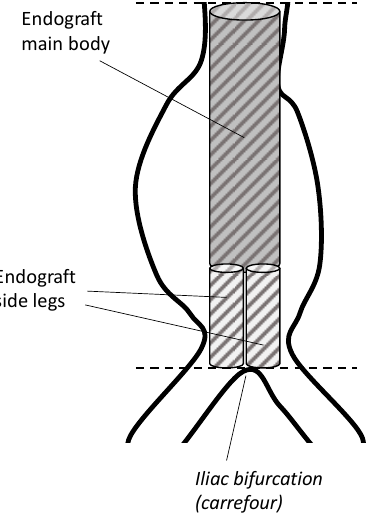
Figure 5. Schematic representation of the estimated endograft volume (the dotted cylindrical shapes).